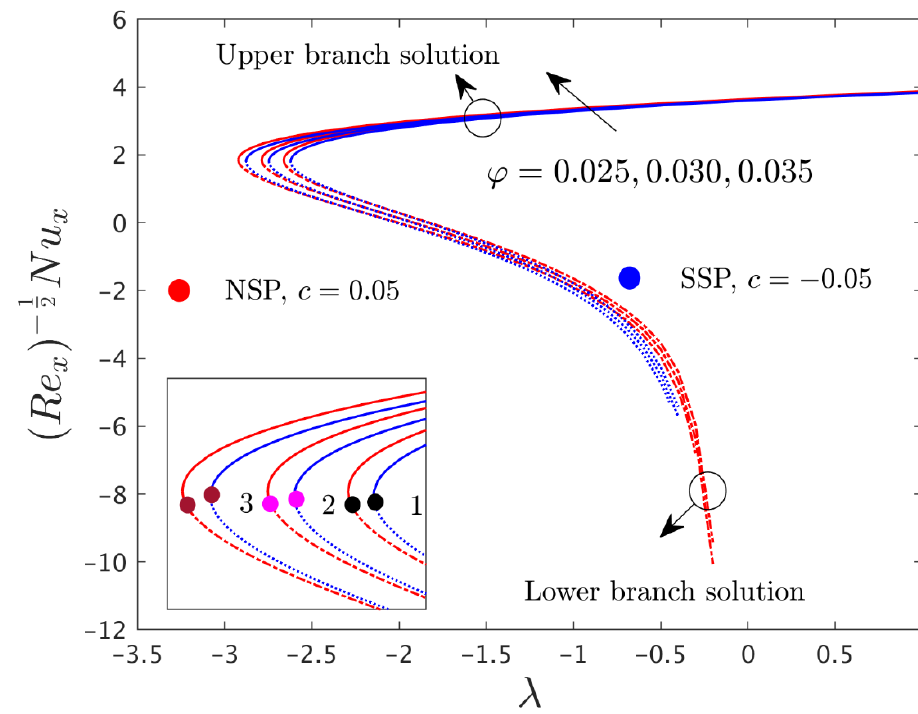
Figure 8. Heat transfer rate Re x − 1/2 Nu x for varying ϕ . The influences of